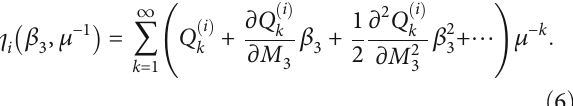
2 against the time t